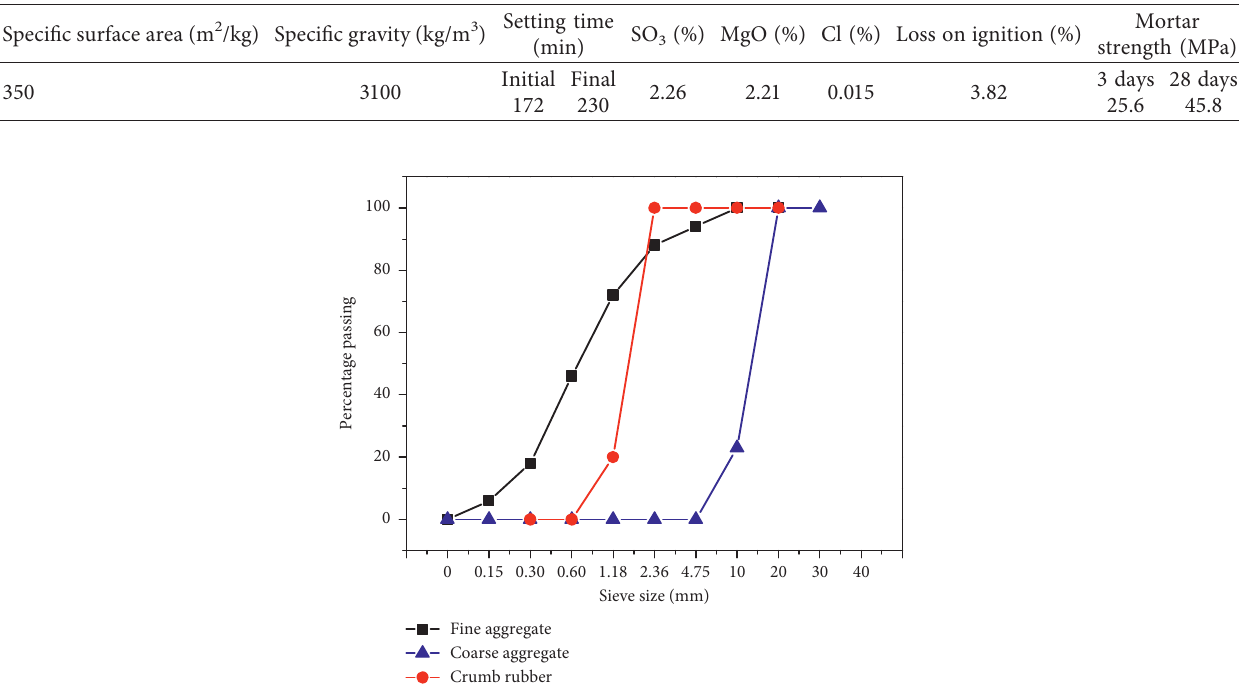
Figure 1: Particle size distribution of aggregates. Table 2: Geometrical and mechanical specifications of the steel fiber.